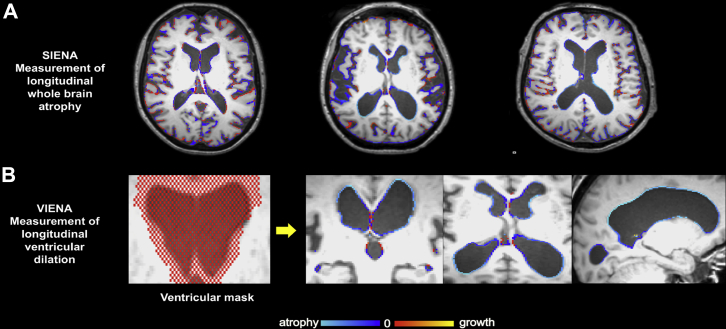
Illustration of imaging pipeline for whole-brain atrophy rates and ventricular enlargement over time. (A) Whole-brain atrophy as quantified by SIENA. Each image shows the changes between baseline and 18 months for each representative subject. Red indicates brain volume increase, whereas blue represents atrophy. (B) VIENA was used to calculate ventricular percentage changes between baseline and 18 months after a ventricular mask (red pixels) were registered to each individual MRI to identify ventricular edge displacements. Abbreviation: VIENA, ventricular enlargement. (For interpretation of the references to color in this figure legend, the reader is referred to the Web version of this article.)